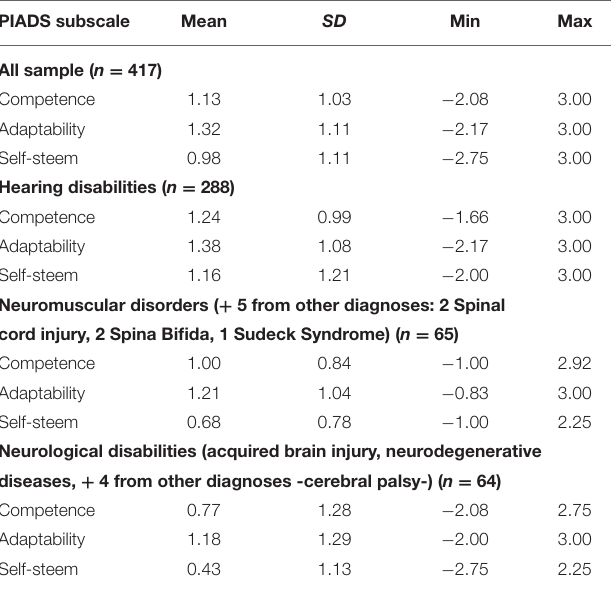
TABLE 2 | Mean, standard deviations, minimum, maximum scores in each subscale of the Spanish (Spain) Psychosocial Impact of Assistive Device Scale by the disability